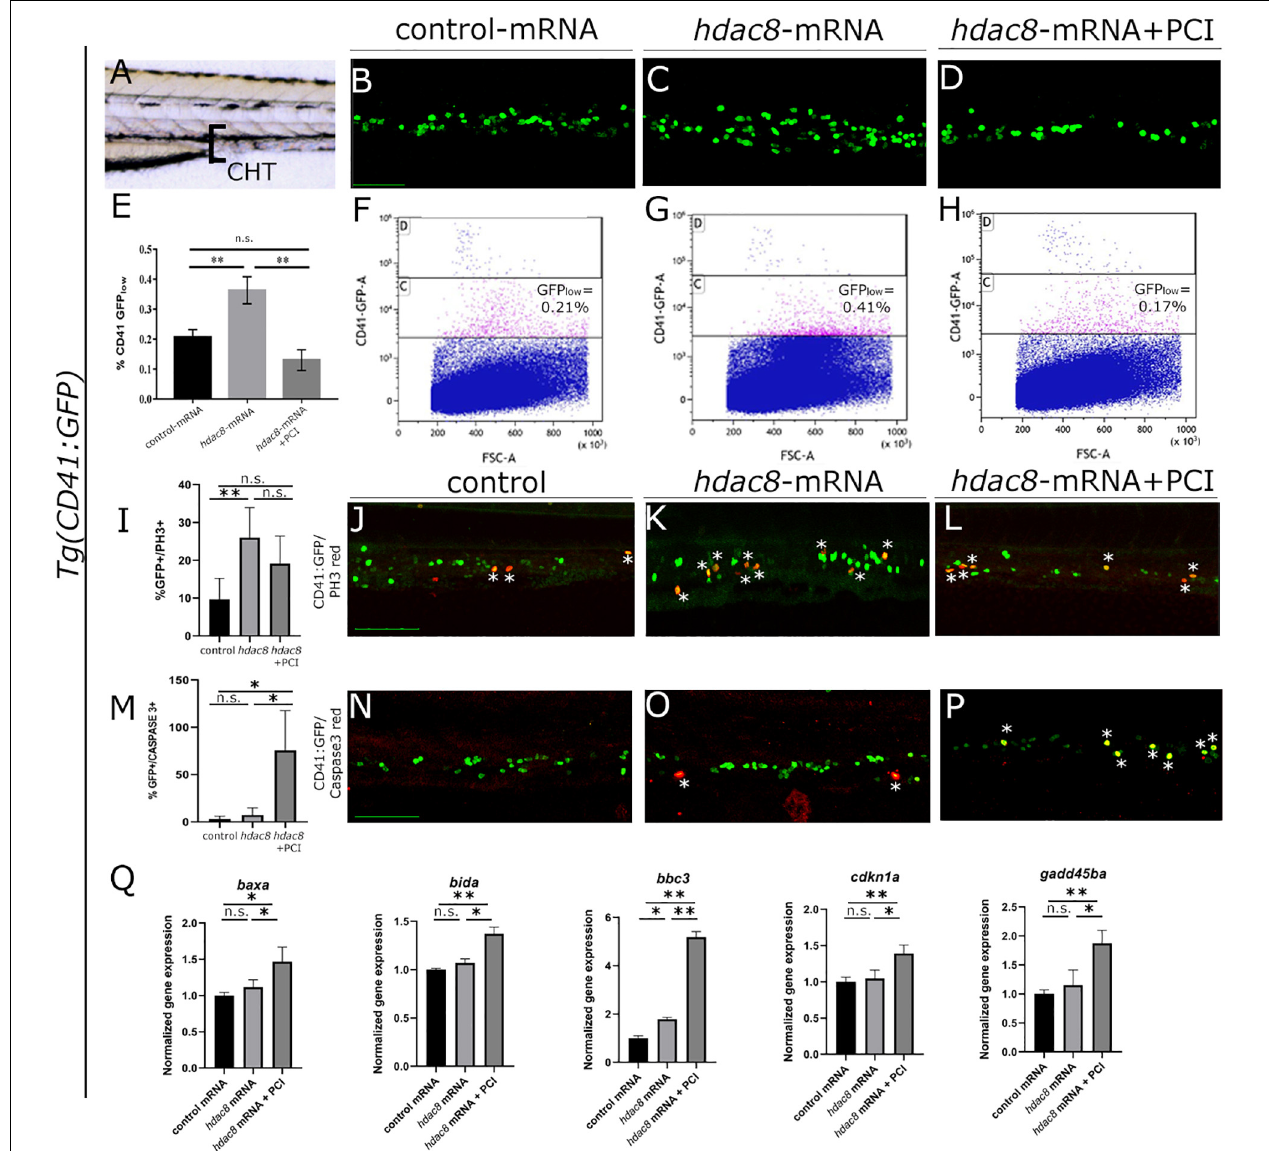
FIGURE 1 | Analysis of Hdac8 overexpression in zebrafish and apoptosis induced by PCI treatment. (A) Scheme of trunk-tail region of zebrafish embryos: confocal imaging was always performed on the same embryo region, comprising the tip of the yolk sack extension, between the dorsal aorta and the vein; representative images of (B) control; (C) hdac8 -mRNA injected; (D) PCI-treated hdac8 -mRNA injected Tg(CD41:GFP ) zebrafish embryos at 3 dpf. Scale bar represents 100 µ m. (E) Quantification by FACS of GFP low -HSPCs of (F) control; (G) hdac8 -mRNA injected; (H) PCI-treated hdac8 -mRNA injected Tg(CD41:GFP ) zebrafish embryos at 3 dpf. The results are presented as mean ± SD from three independent experiments. (I–L) Proliferation of HSPCs in the caudal hematopoietic tissue of the Tg(CD41:GFP) zebrafish line following Hdac8 overexpression and PCI treatment. GFP + HSPCs in green; PH3 in red; quantification in (I) , N = 6 embryos analyzed. (M–P) Apoptosis of HSPCs in the caudal hematopoietic tissue of the Tg(CD41:GFP) zebrafish line following PCI treatment. GFP + HSPCs in green; activated caspase-3 + cells in red; quantification in (M) , N = 3 embryos analyzed. Asterisks indicate double positive cells (yellow). Scale bar represents 100 µ m. (Q) RT-qPCR analyses of apoptotic markers baxa , bida, bbc3, cdkn1a, and gadd45ba expression in control mRNA and hdac8 -overexpressing zebrafish embryos treated with DMSO or PCI. The results are presented as mean value ± SD from three independent experiments. * p < 0.05, ** p < 0.01, n.s. = not significant, one-way ANOVA followed by Tukey post hoc